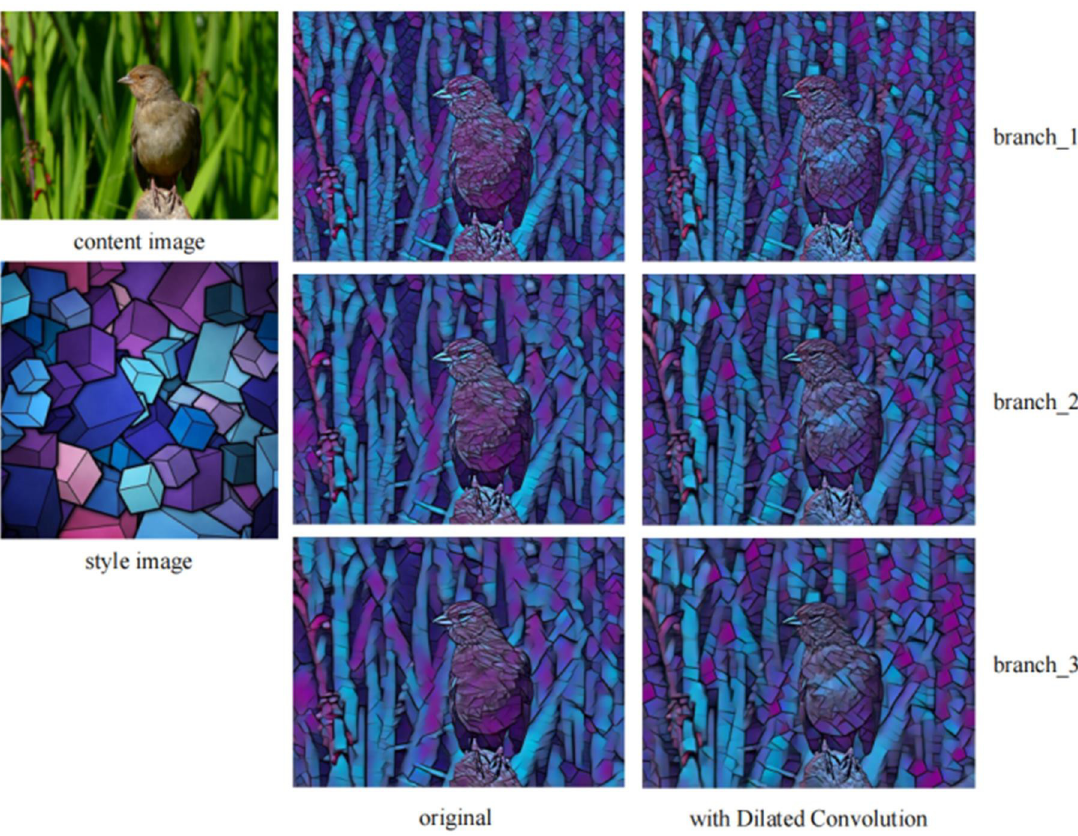
Fig 7. Comparison of the effect before and after the introduction of cavity